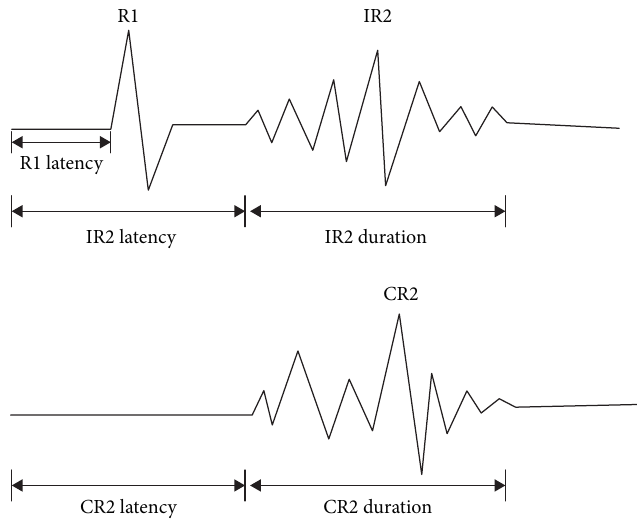
Figure 2: Schematic of blink re fl ex. Abbreviations: IR2: ipsilateral R2; CR2: contralateral